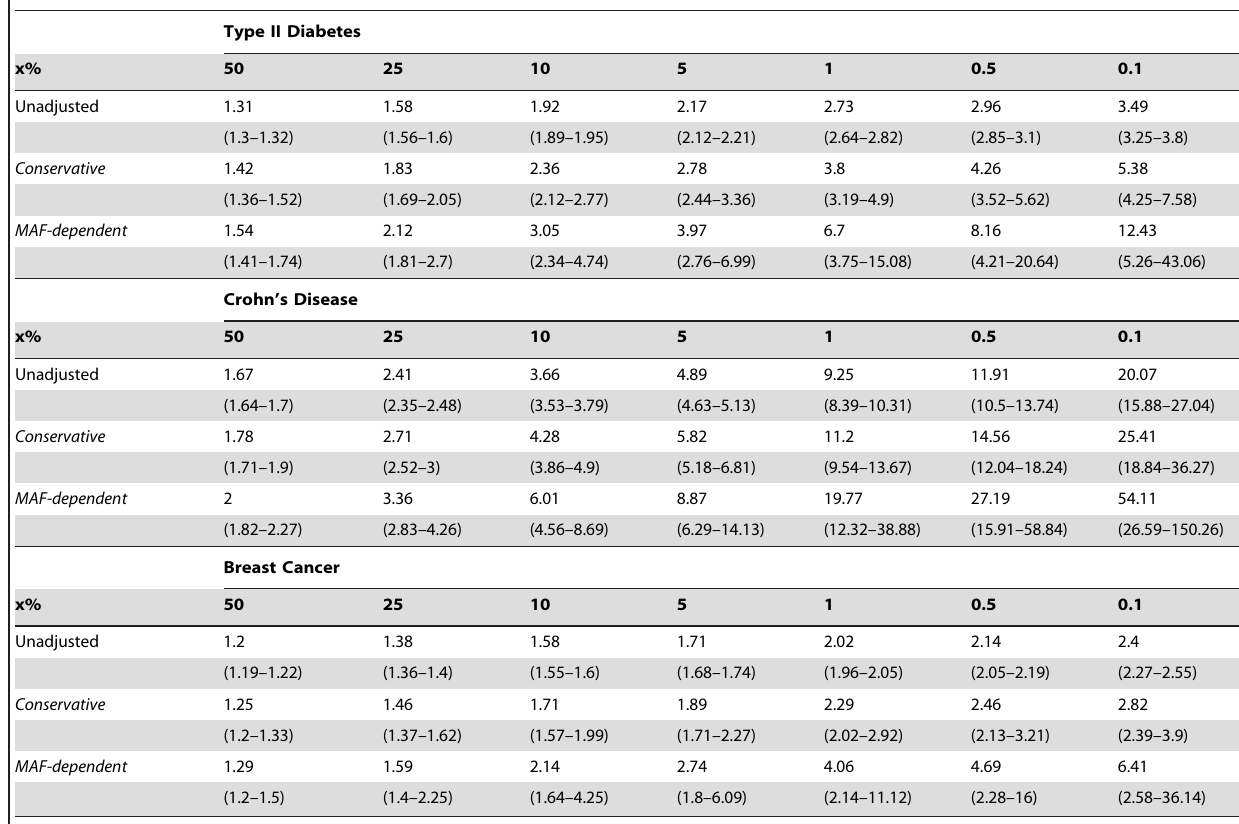
Table 1. Adjusted estimates of individual